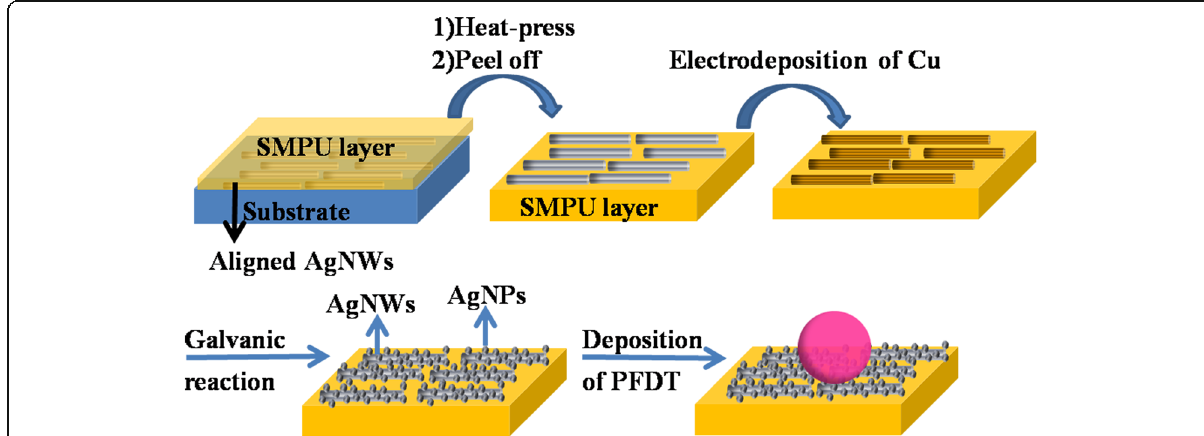
Fig. 1 Schematic illustration of the fabrication process for flexible and superhydrophobic AgNWs@AgNPs films. The concentrating effect of the superhydrophobic substrates, and the prepared flexible substrate and the SMPU film